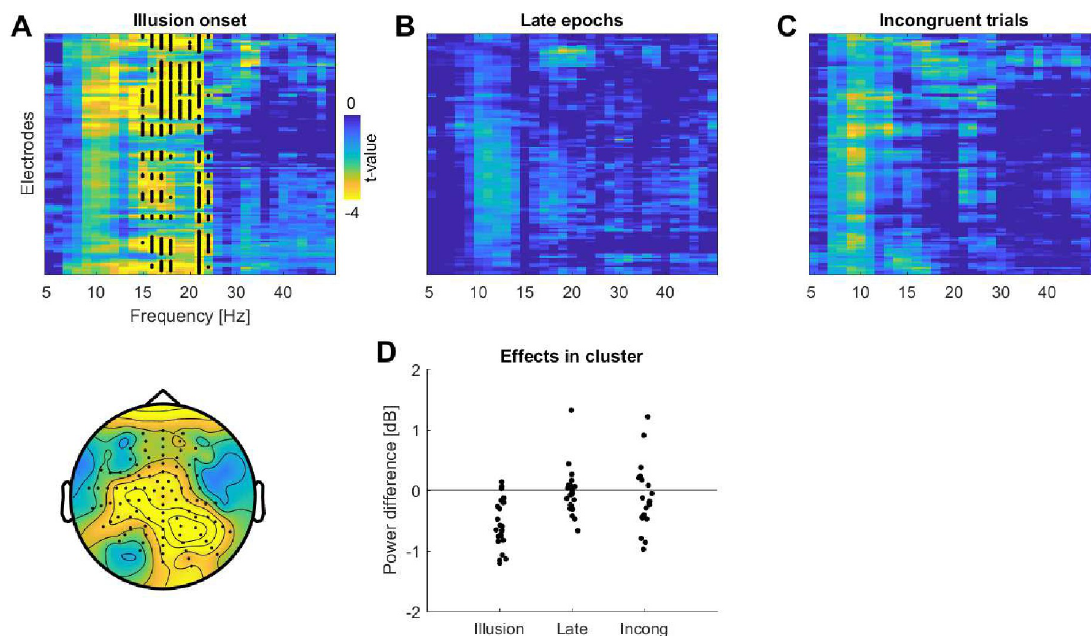
Fig 5. Changes in spectral power around illusion onset and at control time points. A) Contrast between the power between epochs immediately prior to the illusion onset and the epochs immediately after the onset. B) Contrast between the epochs taken from a later period of the Illusion condition. C) Contrast between epochs in the Incongruent condition prior and subsequent to the times of the illusion onset in the Illusion trials. Panels A-C show the electrode and frequency wise t-maps for a difference between epochs (two-sided t- test, showing post illusion onset minus prior to illusion epochs). The lower panel in A) shows the scalp topography at the frequencies of the significant cluster. D) Shows the participant-wise power differences between conditions for the electrodes and frequencies derived from the significant cluster in